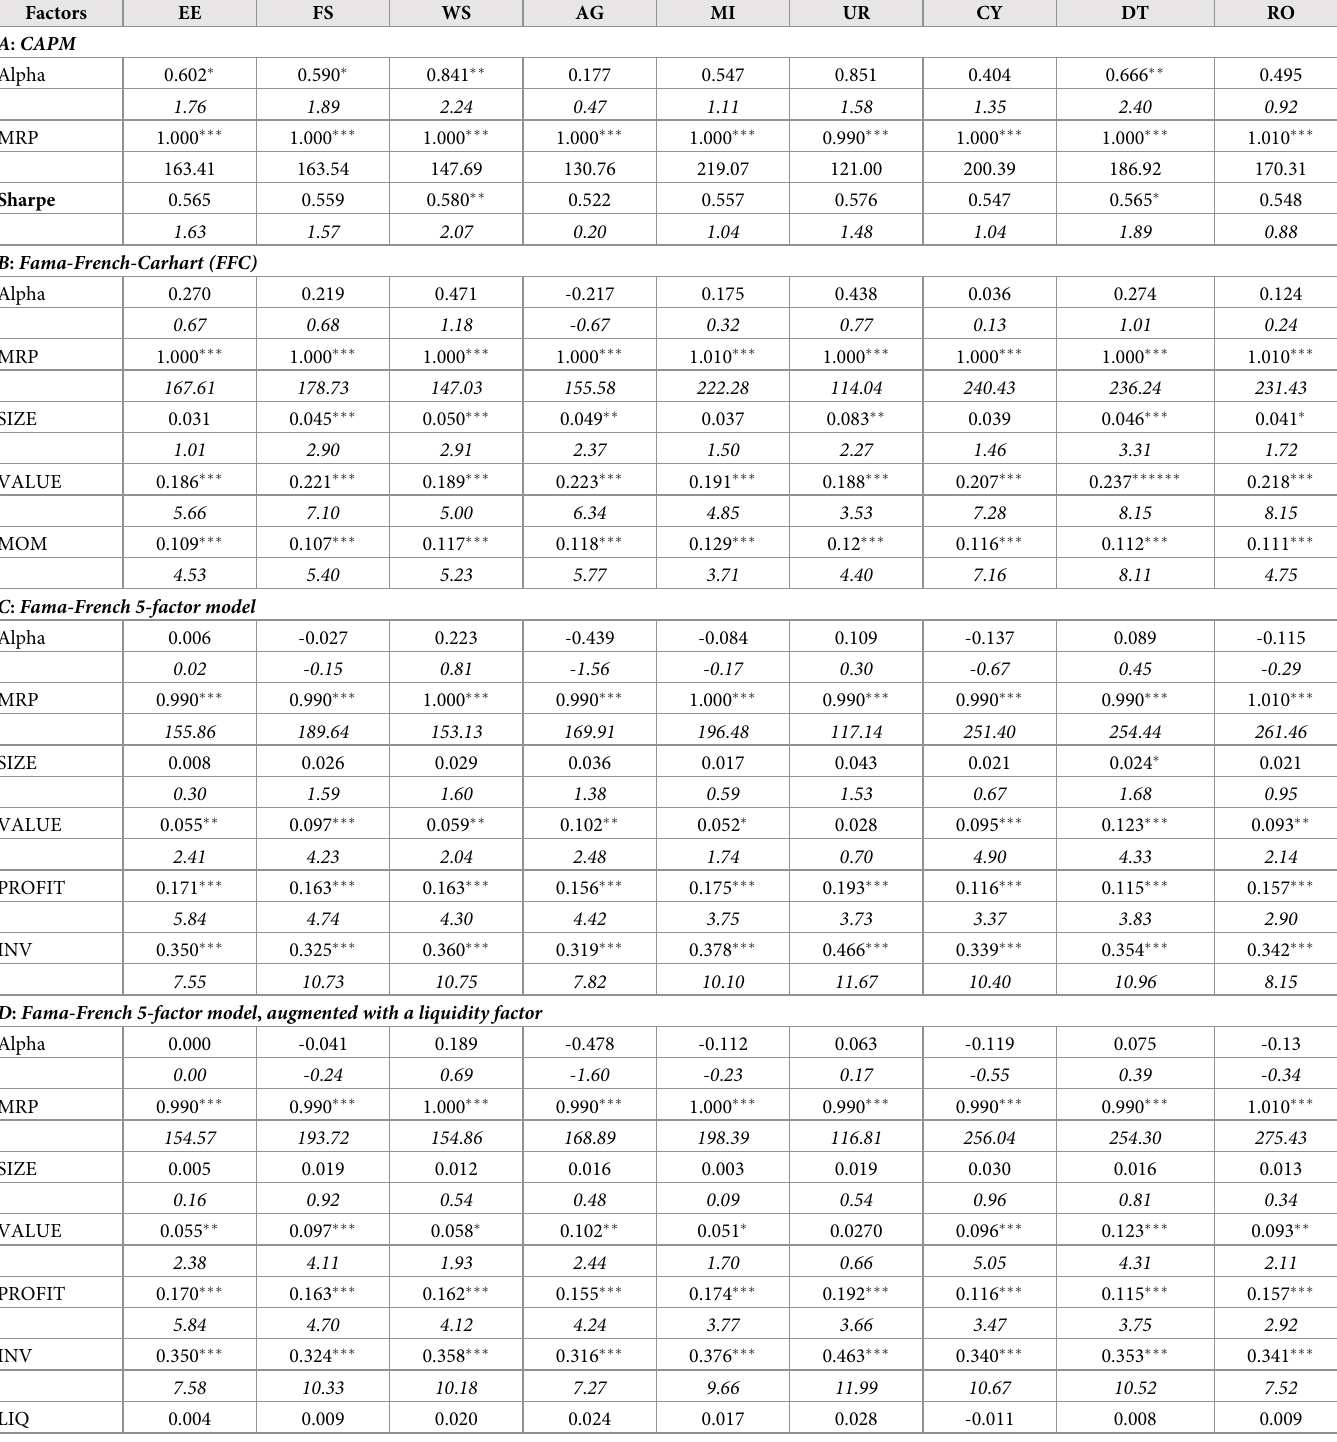
Table 4. Regressions of megatrend portfolios on pure factor portfolios via